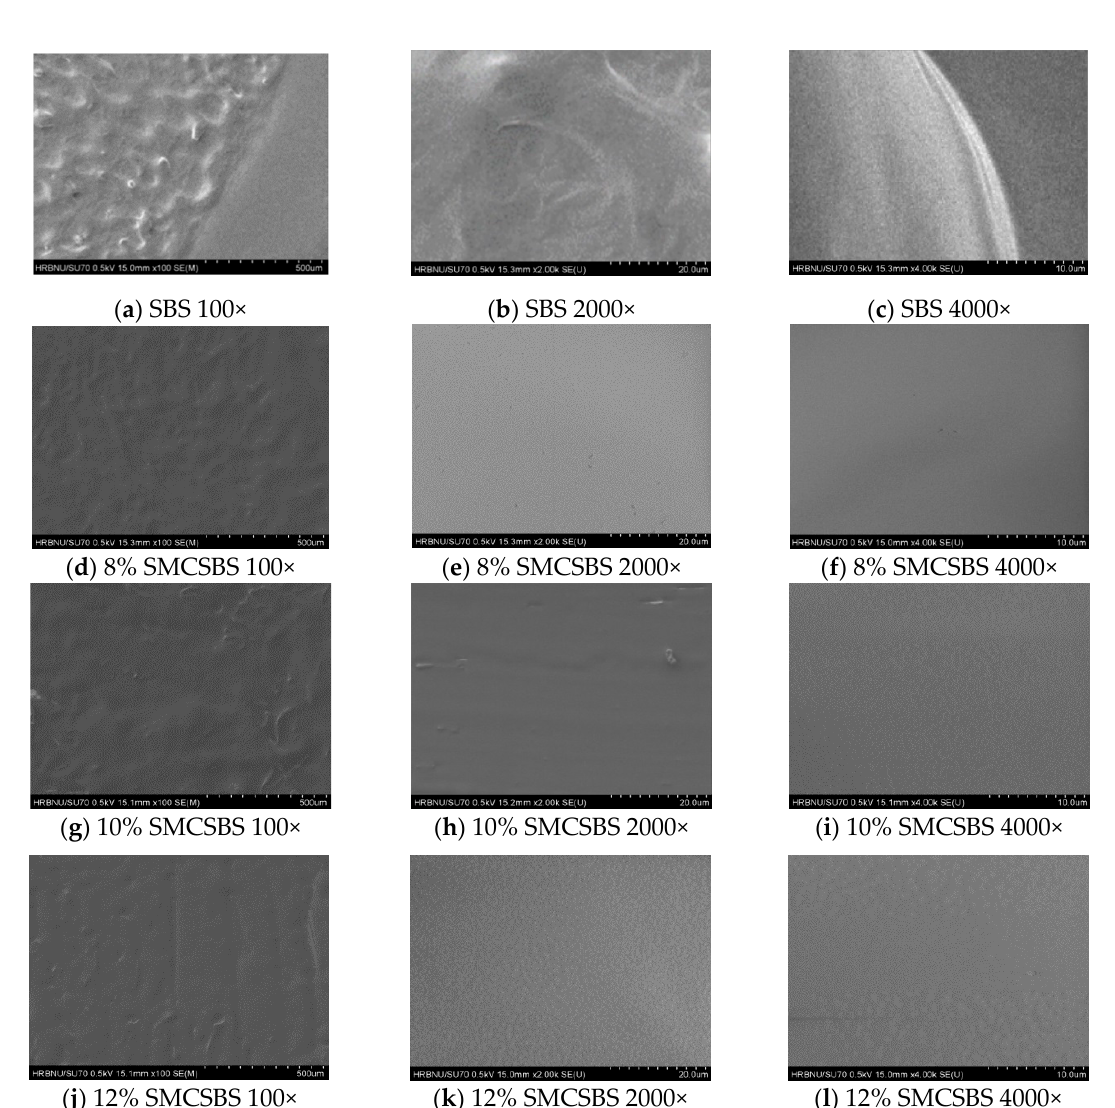
Figure 7. ( a ) SBS 100×; ( b ) SBS 2000×; ( c ) SBS 4000×; ( d ) 8% SMCSBS 100×; ( e ) 8% SMCSBS 2000×; ( f ) 8% SMCSBS 4000×; ( g ) 10% SMCSBS 100×; ( h ) 10% SMCSBS 2000×; ( i ) 10% SMCSBS 4000×; ( j ) 12% SMCSBS 100×; ( k ) 12% SMCSBS 2000×; and ( l ) 12% SMCSBS 4000×.